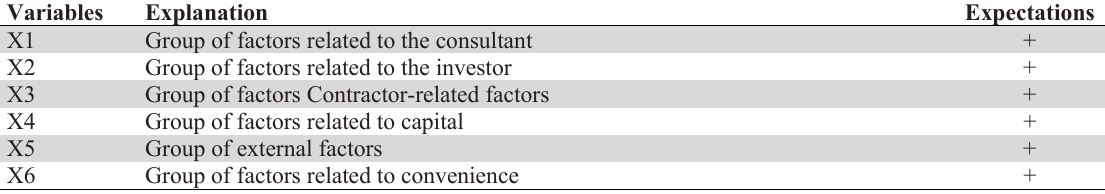
Interpretation of independent variables in the linear regression model Variables